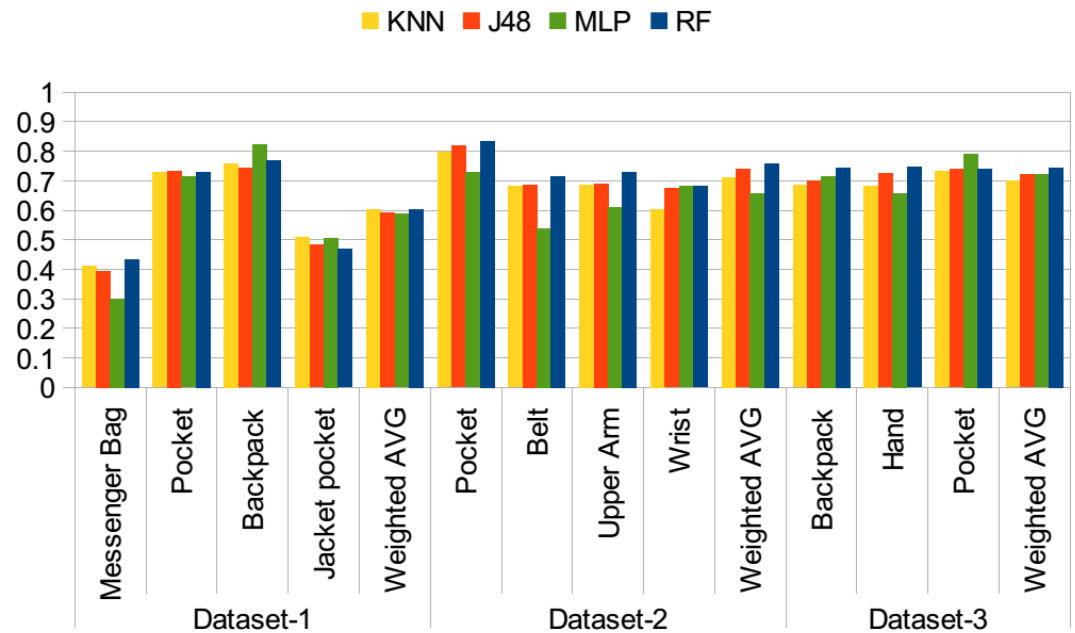
Figure 4. Position recognition performance with only motion features.